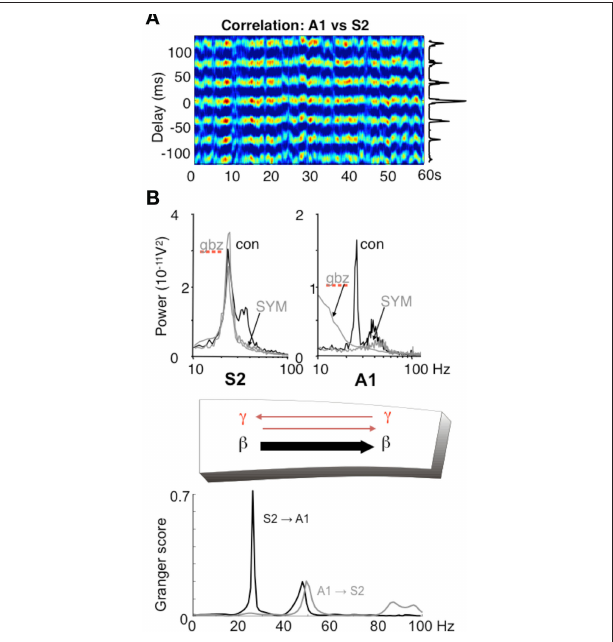
Figure 6 | Different rhythms allow for directionality in functional connectivity. (A) Cross-correlogram showing a highly stable phase relationship between association cortex (S2) and primary auditory cortex (A1) when both generate beta2 frequency (c. 25 Hz) oscillations driven by kainate in the presence of cholinergic neuromodulation. (B) While the beta2 frequency rhythms in each area are spectrally the same, the mechanisms underlying them at the local network level are not. S2 beta2 rhythms are almost completely resistant to blockade of fast glutamatergic (SYM = SYM2206, 20 μM) or GABAergic (gabazine, 500 nM) synaptic transmission, whereas the same frequency generated by A1 requires both these components of synaptic transmission. The resulting combination of a rhythm dependent on chemical synaptic activity and one resistant to it results in highly significant partial directed coherence estimates (Granger scores) within the beta2 frequency band: The relatively synaptically inert S2 beta2 rhythm is able to dominate over the synaptically labile A1 beta2 rhythm. Note that in both regions, the accompanying superficial layer gamma rhythm is abolished by synaptic blockade and that, for the gamma rhythm, interactions are bi-directional. Figure from Roopun et al.